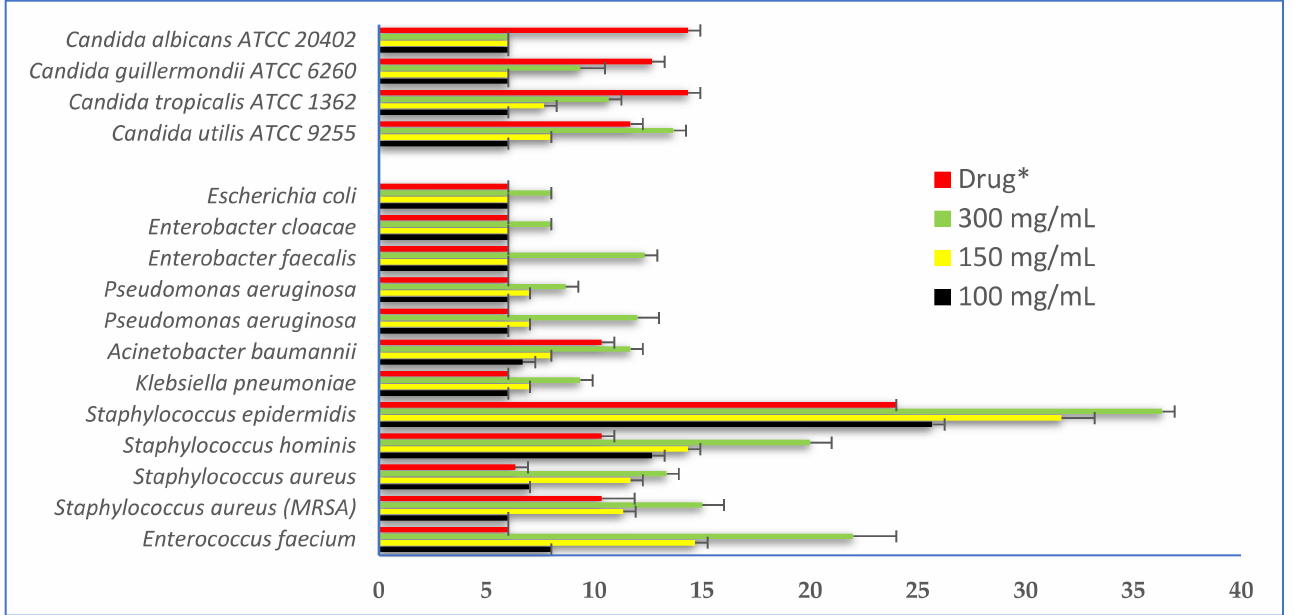
Figure 3. Mean diameters of bacterial and fungal growth inhibition zones (mGIZ ± mm) obtained with different concentrations of D. flabellifolia hydro-methanolic extract as compared to standard drugs. *: Ampicillin for bacteria and amphotericin B for Candida